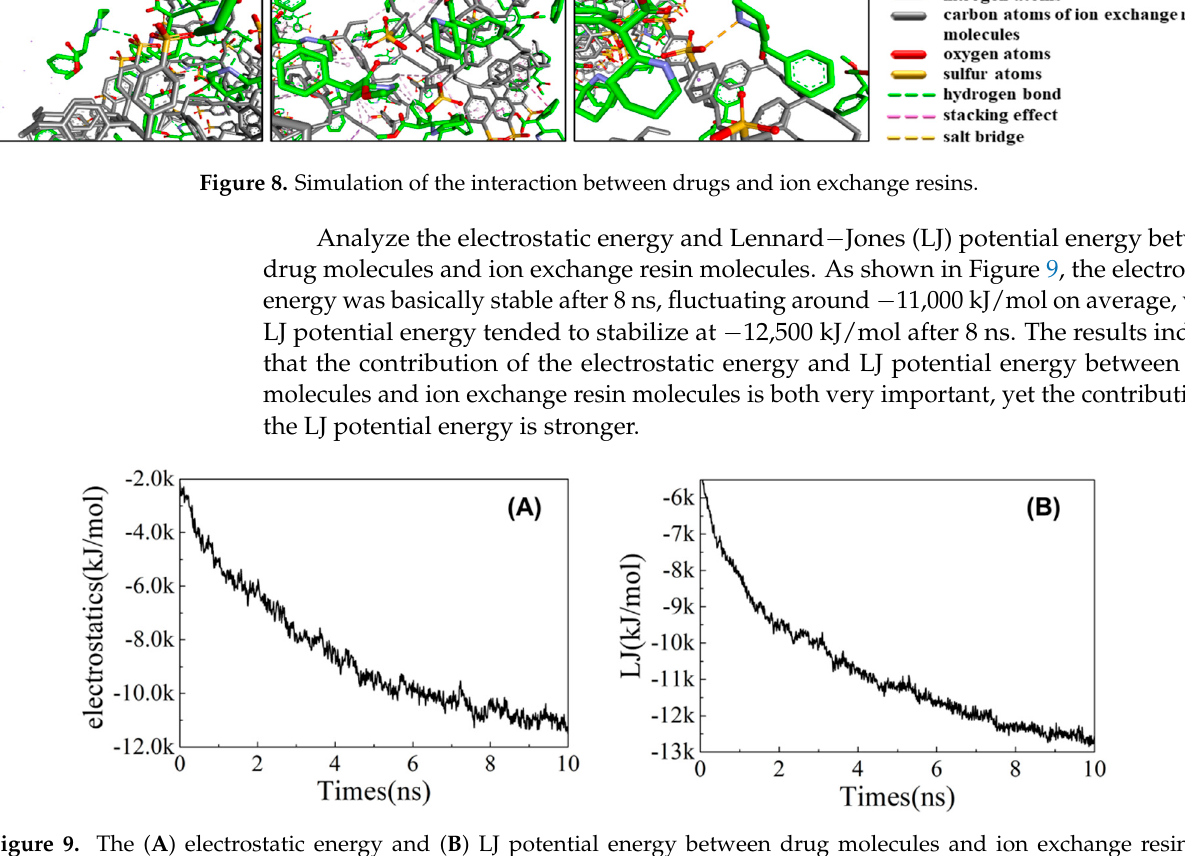
Figure 9. The ( A ) electrostatic energy and ( B ) LJ potential energy between drug molecules and ion exchange resin molecules vs. times.